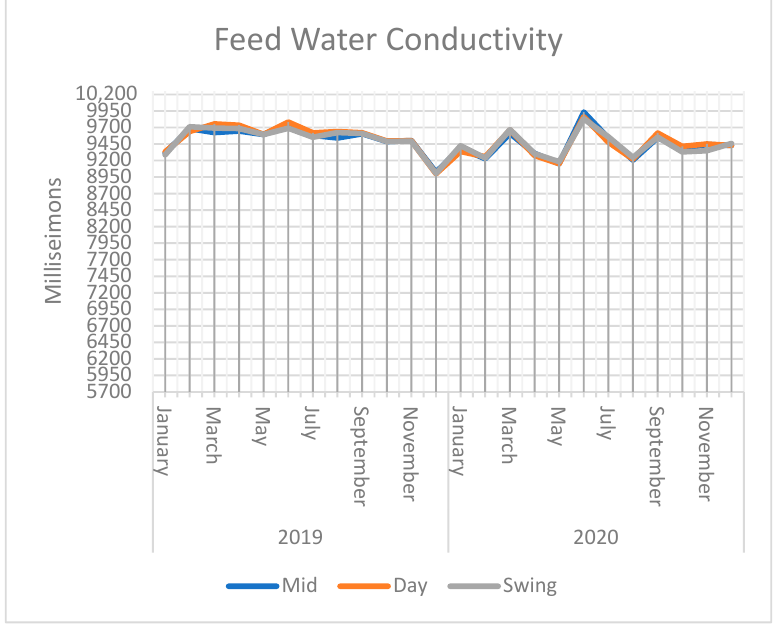
Figure 11. Conductivity of the feed water for 2019 and 2020. The mean is near 9400 millisiemens, which is an estimated TDS of 4700 mg/L or a dissolved chloride value of about 2585 mg/L.